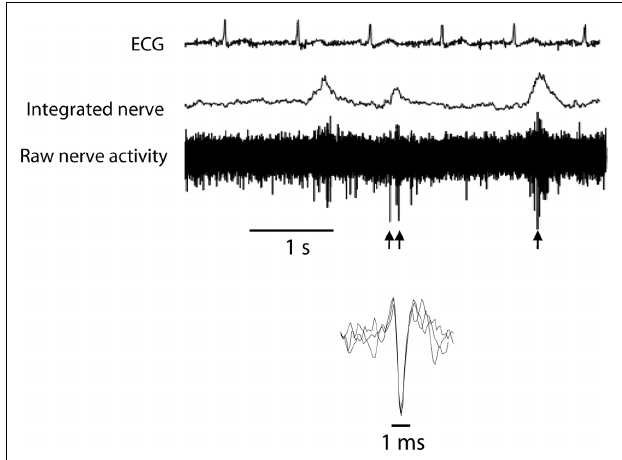
FIGURE 1 |Typical recording of single-unit and multi-unit muscle sympathetic nerve activity (MSNA). Single-unit MSNA was identified on the raw nerve and highlighted by the arrows. Superimposed spikes demonstrate consistent